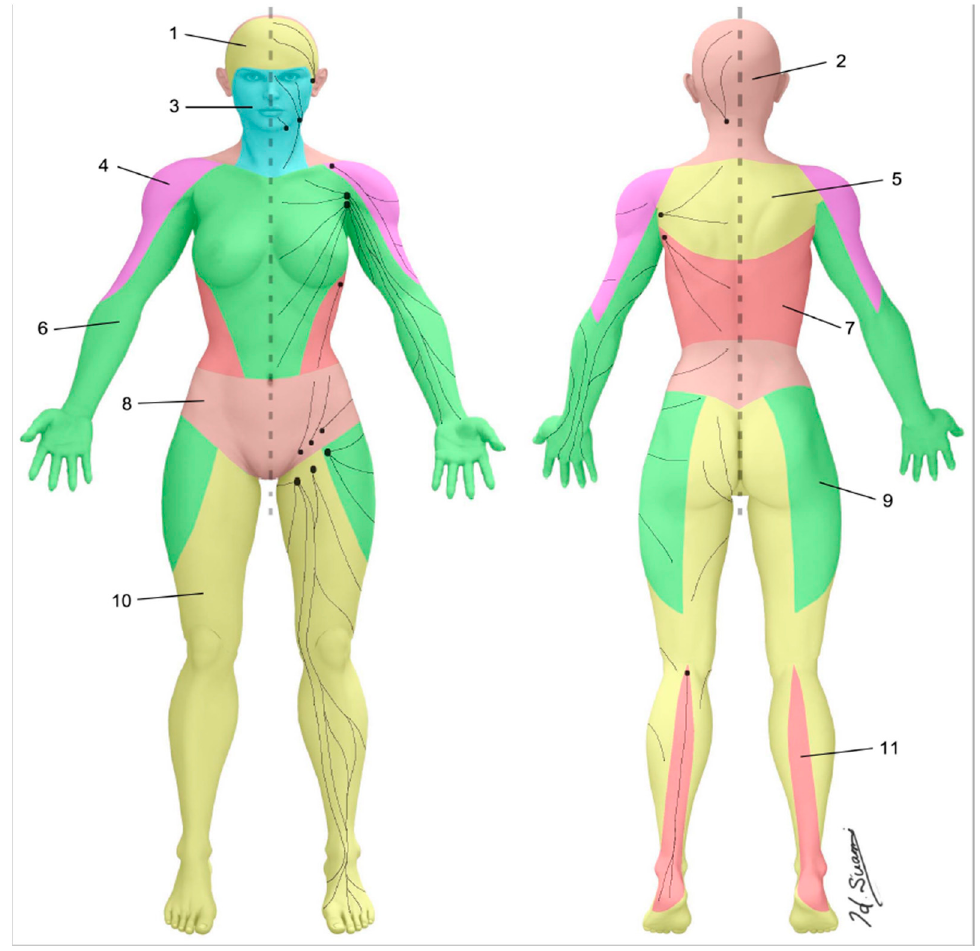
Figure 3. Lymphosomes of the body. The lymphatic territories are demarcated according to their corresponding lymphatic basins: (1) temporal, (2) occipital, (3) submental, (4) subclavicular, (5) subscapular, (6) lateral axillary, (7) pectoral, (8) superior inguinal, (9) lateral inguinal, (10) inferior inguinal, (11) popliteal. (Reproduced with permission of Hiroo Suami).